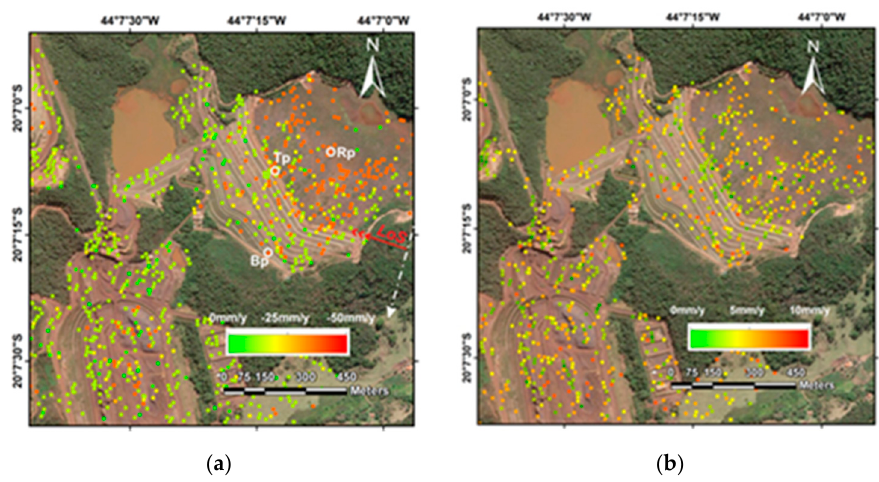
Figure 8. Maps of the displacement rate ( a ) and the standard deviation ( b ) from the PSI analysis; white circles represent the analyzed points in the dam reservoir ( Rp ), crest ( Tp ) and bottom face ( Bp ). The distribution of the MPs with accumulated deformations depicted over a 3D perspective view of using WorldDEM and a Worldview image is presented in Figure 9. It can be observed that the maximum values of deformations, around –70 mm, were detected on the tailings (reddish dots). Some sectors of the dam face presented MPs with deformations up to − 40 mm (orangish dots).